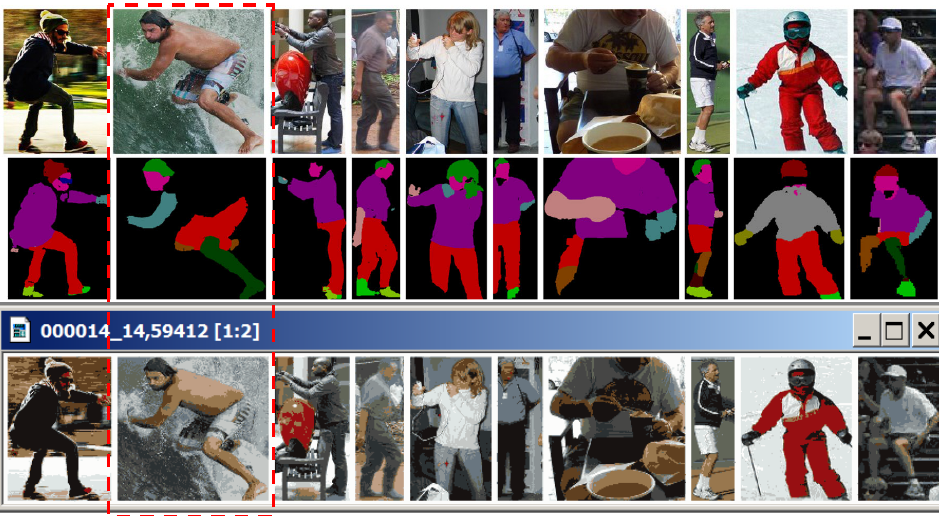
Figure 14. Customizable selection of desired object hierarchy. The input composite image from [46] is displayed in the top line. The middle line shows the result of object detection according to [46], where the surfer’s body is poorly detected. The bottom line shows the proposed method results using g 0 = 3, g = 14.